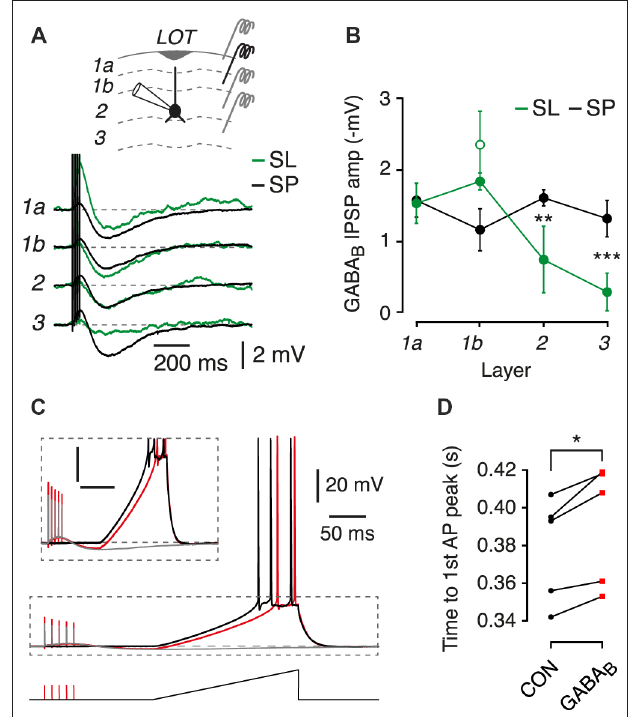
FIGURE 1 | Properties of a postsynaptic GABA B receptor-mediated response in semilunar (SL) and superficial pyramidal (SP) cells in layer 2 of the piriform cortex (PC). Inset at top shows a schematic of the experiment configuration. LOT, lateral olfactory tract. (A) Layer 1 stimulation (five pulses at 100 Hz) evokes a slow hyperpolarization (black trace) that is blocked by 5 µ M CGP55845 (red; each trace is an average of 10 episodes; SP cell shown). (B) Mean peak amplitude of the postsynaptic GABA B receptor response, normalized to the mean amplitude during the baseline period, plotted vs. time ( n = 7 SL and SP cells). Normalized amplitude decreases after bath application of CGP55845 (red bar). Error bars show ± SEM. (C) Typical voltage-clamp experiment for determining the reversal potential of the GABA B -mediated postsynaptic current. Each trace is an average of four episodes, each at the indicated holding potential. Stimulus as in (A) . Data are from an SP cell. (D) Mean current-voltage plot for the cell in (C) . Blue line is a linear fit, giving an estimated reversal potential of − 91 mV in this example. Error bars show ± SD.